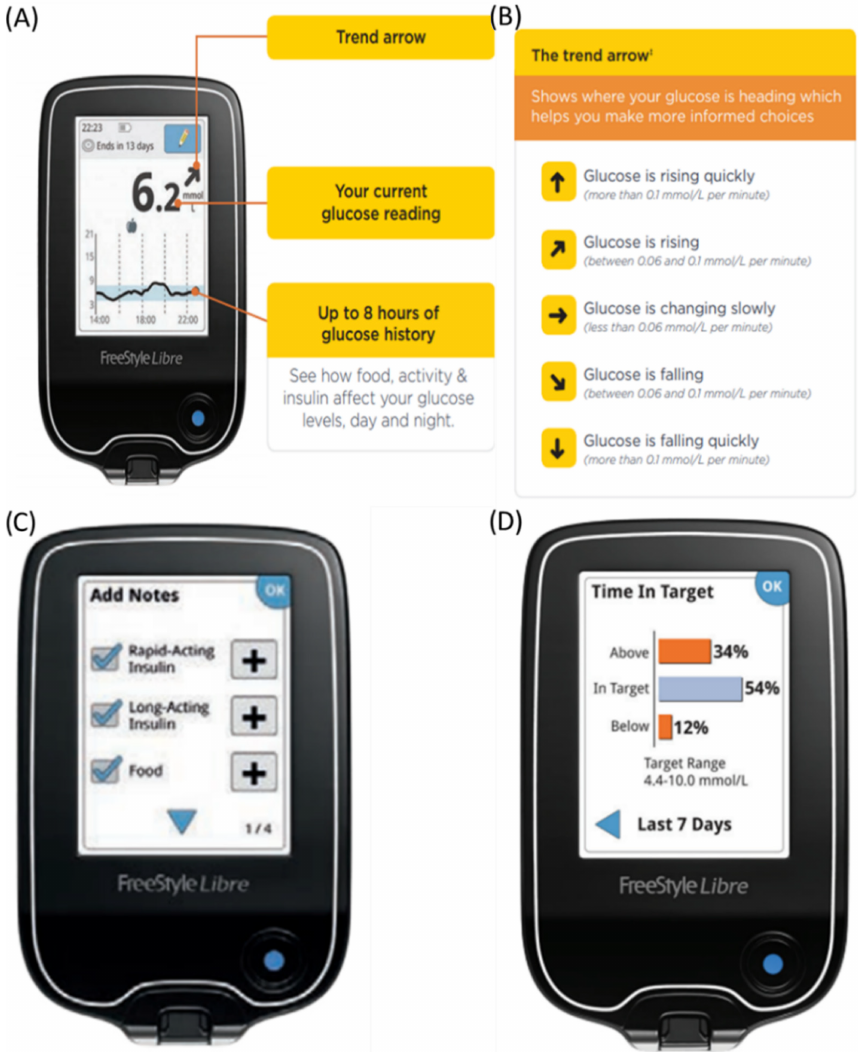
Figure 3. ( A ) General display of rtCGM indicating the predicted direction of glucose level as shown by the trend arrow, the current glucose reading and eight hours glucose history graph; ( B ) Description of the trend arrows; ( C ) Display option of adding notes at a specific time; ( D ) History of glucose levels based on time in targeted